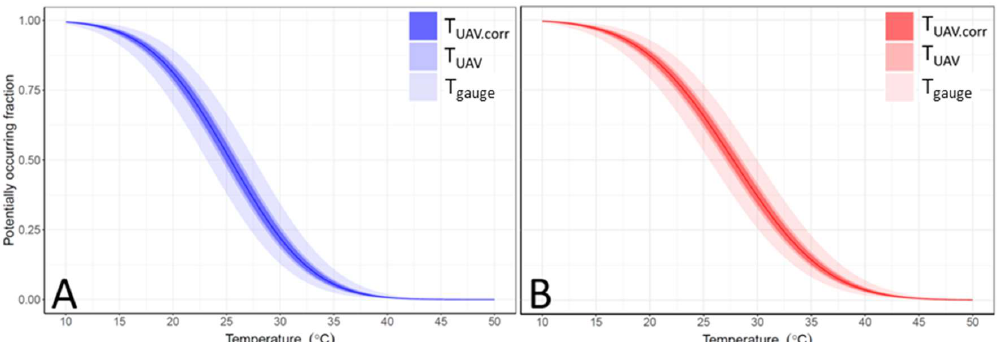
Figure 10. Uncertainty in potentially occurring fraction (POF) due to propagation of temperature errors for ( a ) native species and ( b ) alien species. Temperature errors are the mean difference between the in-situ measured temperatures (T Ref.10 ) compared to 1) the corrected thermal images (T UAV,corr ; light shade), 2) the thermal images collected using an UAV (T UAV; medium shade) and 3) the measured temperature at the gauging station of Lobith (T gauge ; dark shade).